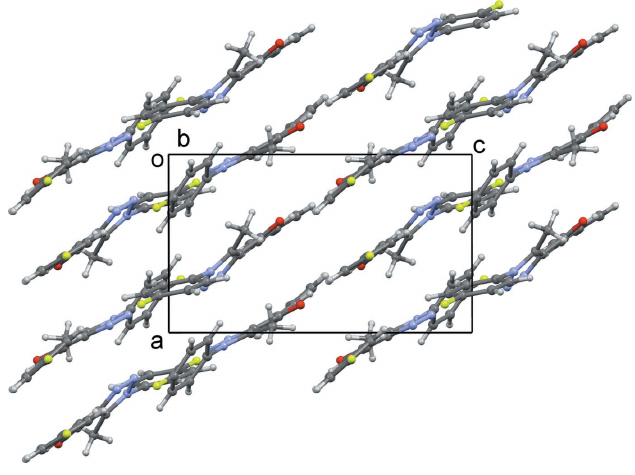
Figure 3 Crystal packing showing layers parallel to (101).